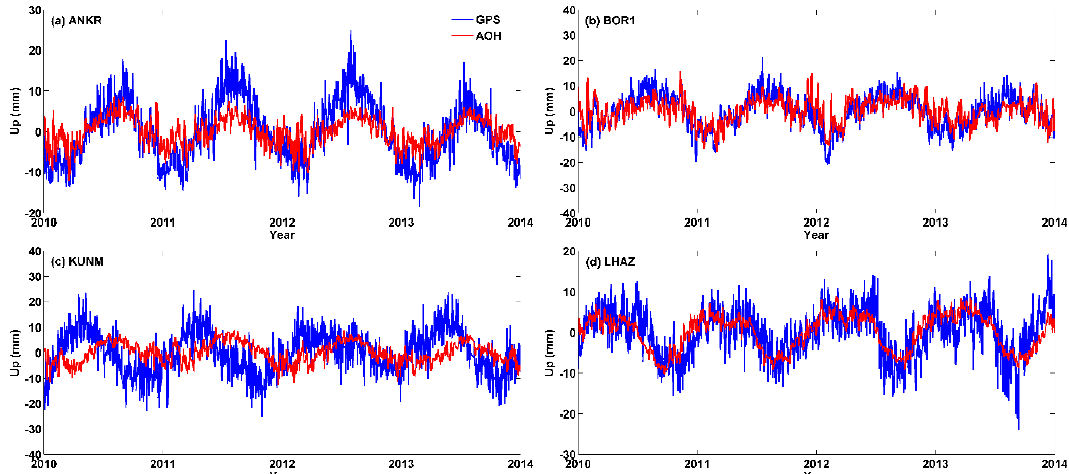
Figure 2. GPS height time series (blue) and atmospheric, oceanic and hydrological loading (AOH) deformation time series (pink) for ( a ) Ankara, Turkey (ANKR); ( b ) Borowiec, Poland (BOR1); ( c ) Kunming, China (KUNM); and ( d ) Lhasa, China (LHAZ).